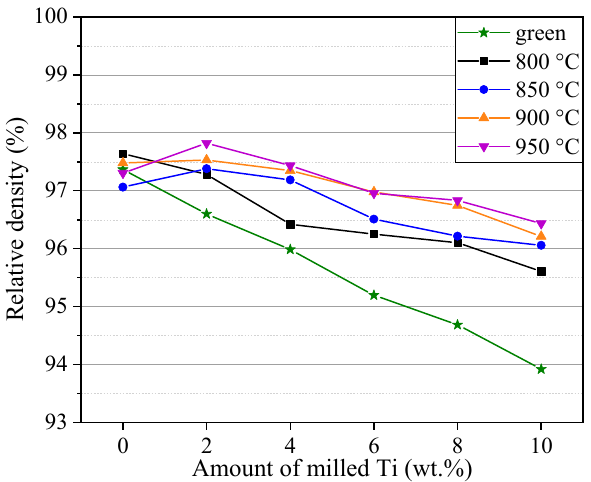
Figure 5. Relative density of the samples containing different amount of milled Ti.